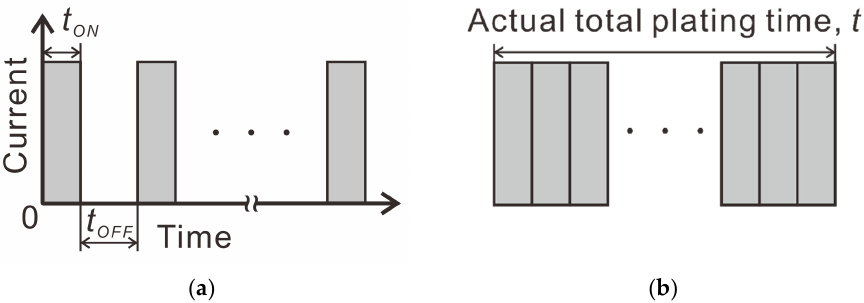
Figure 2. ( a ) Schematic drawing of a pulse current wave and ( b ) the definition of actual total plating time, sum of ON-time for PC plating. Table 1. Parameters of plating condition.